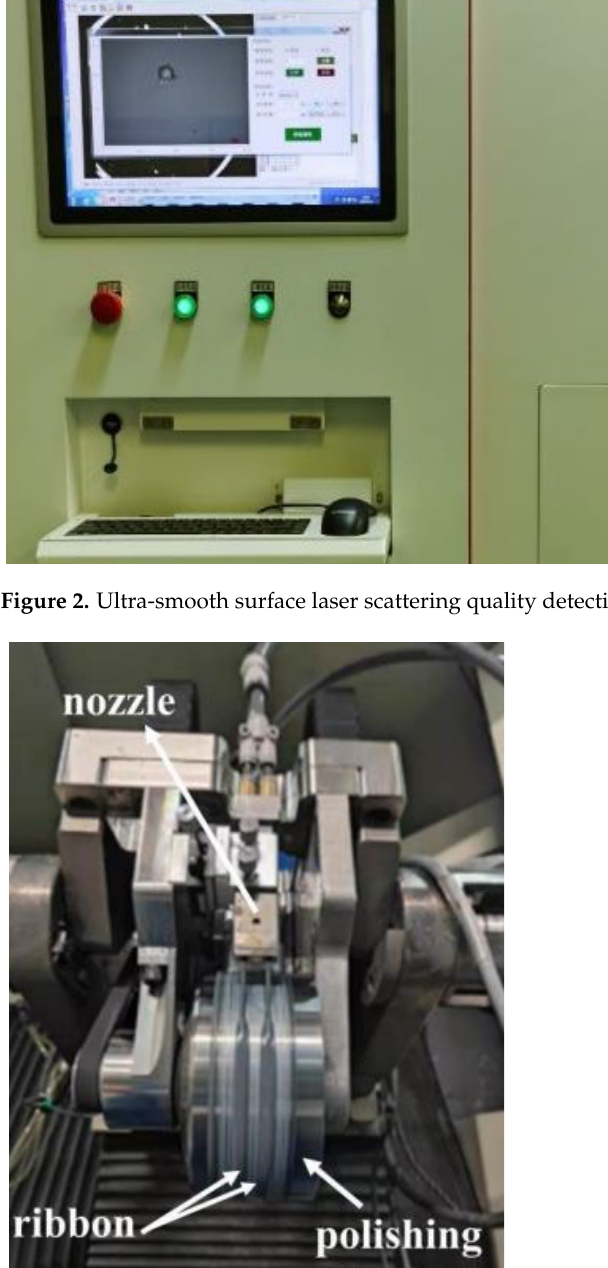
Figure 3. Array-type magnetorheological polishing device.